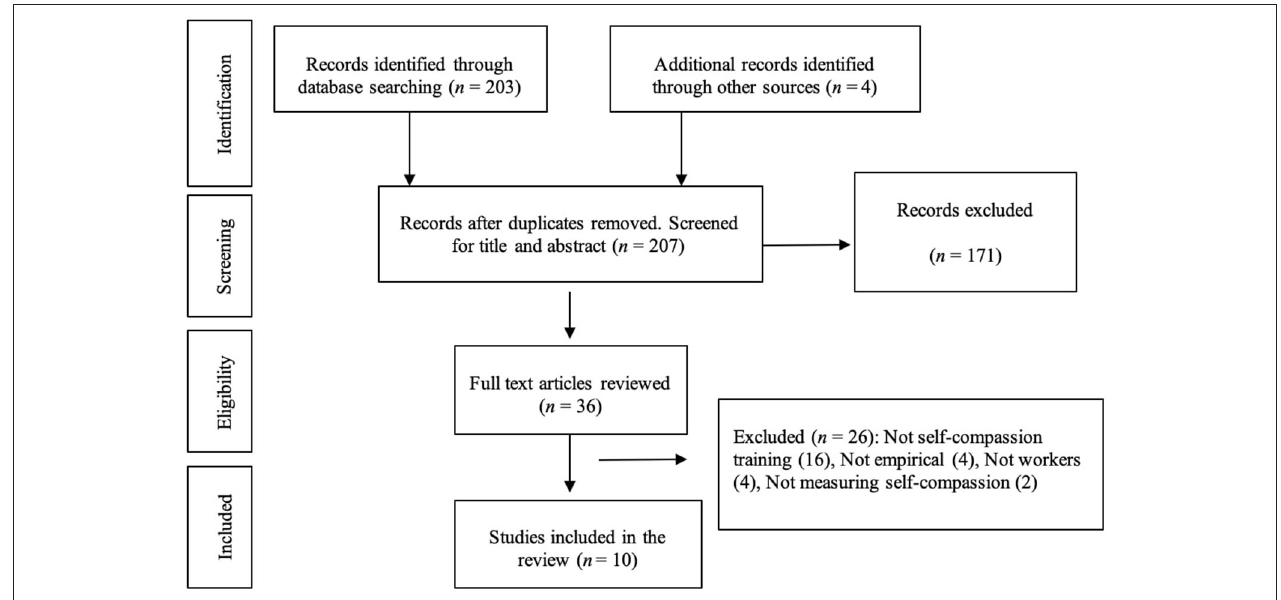
FIGURE 1 | PRISMA flow diagram of the article selection